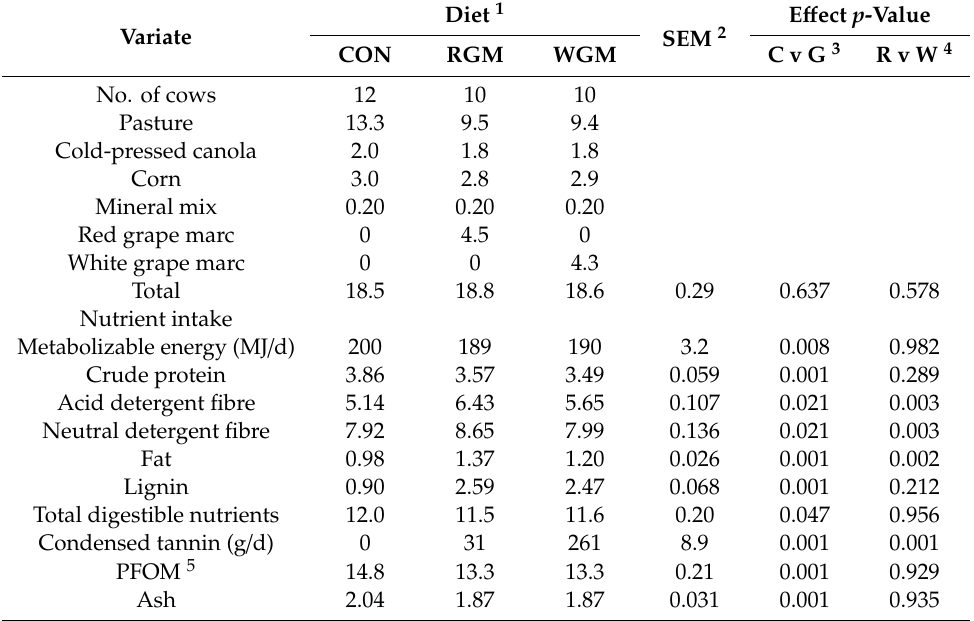
Table 4. Influence of diet on feed and nutrient intake (kg DM / d unless specified otherwise).